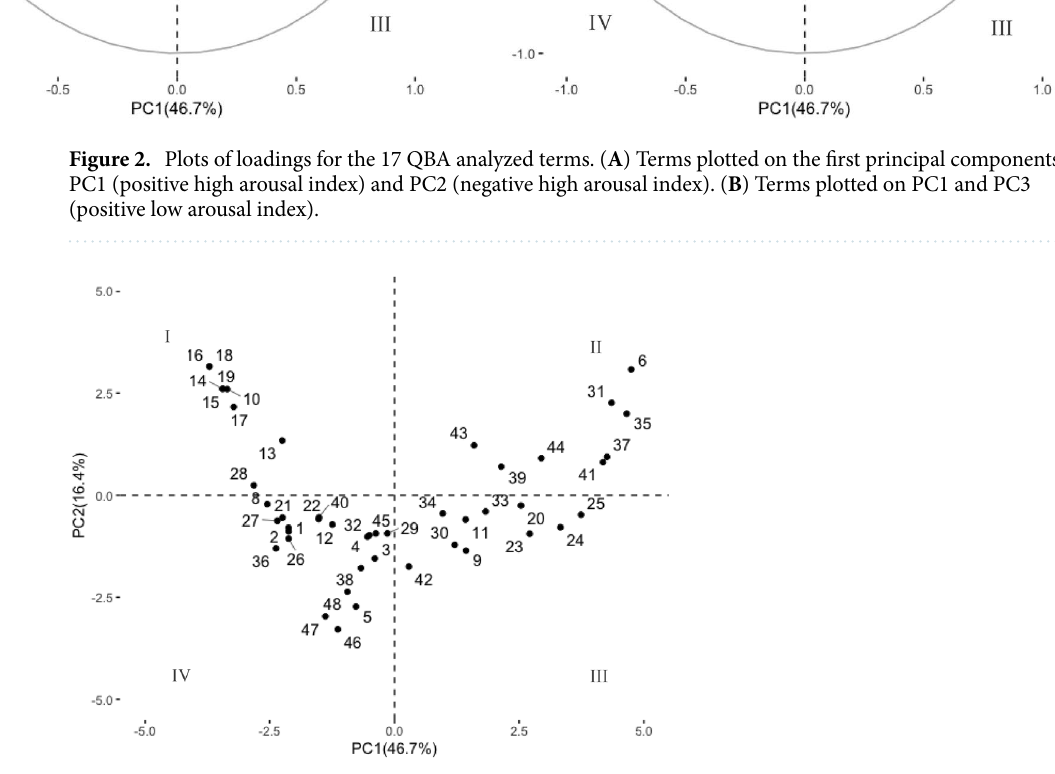
Figure 3. Coordinates of litter emotional states to each piece of music.